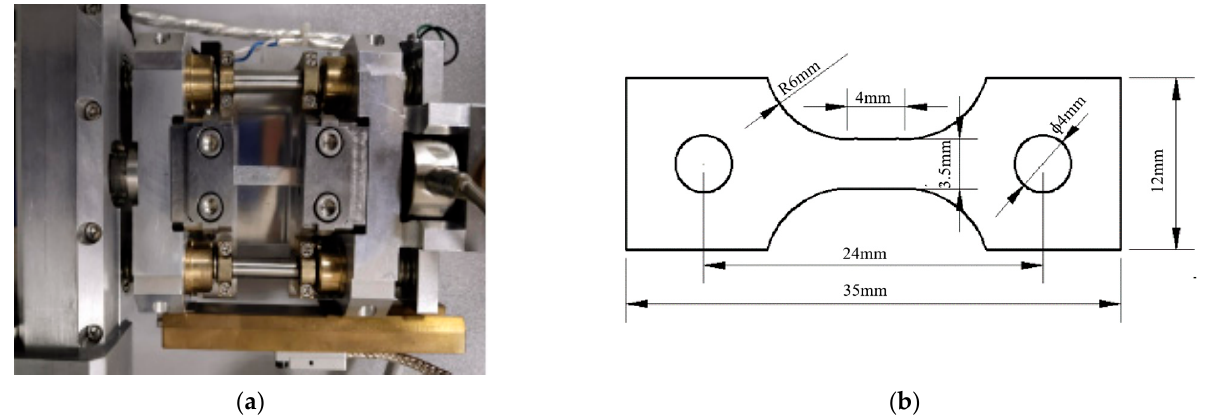
Figure 1. In situ stretching table and sample size. ( a ) In situ tensile test bench; ( b ) size of in situ tensile